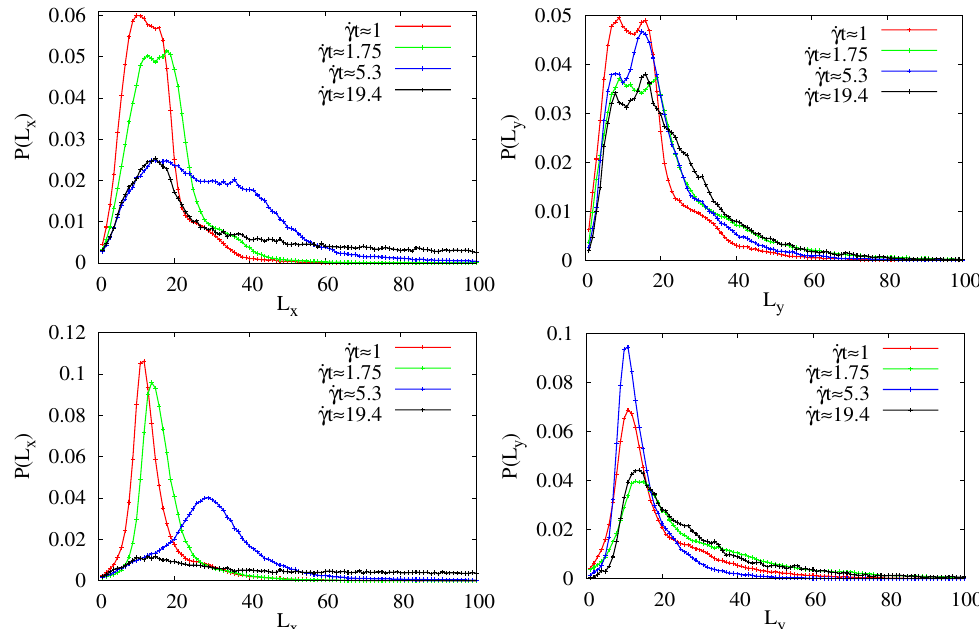
Figure 7. Probability distribution functions P of domains of length L x ( left panels) and L y ( right panels) with λ = 3 ( upper row) and λ = 0 ( lower row) in the weak shear